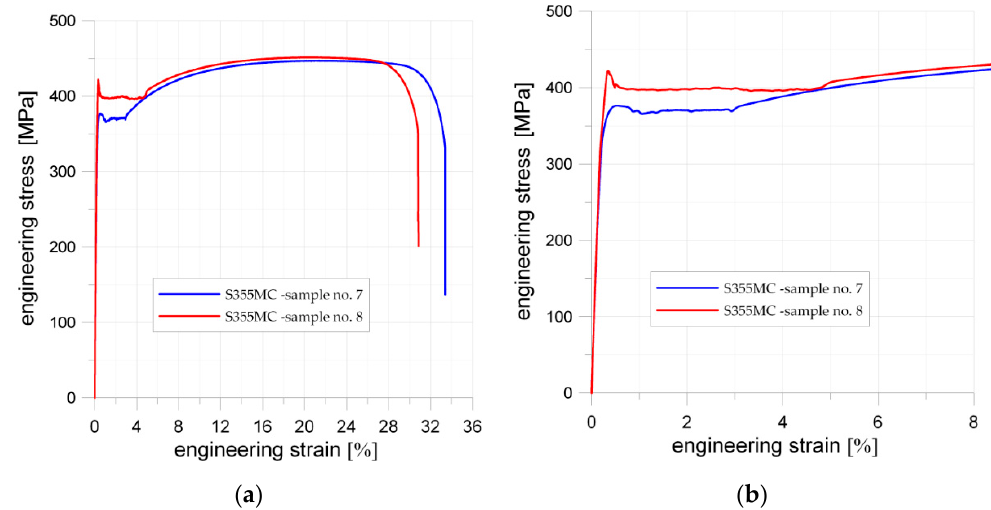
Figure 16. Tensile behavior of S355MC: ( a ) engineering σ – ε curves for tested specimens; and ( b ) engineering stress–strain curves for tested specimens—enlargement of the curve with elastic and plastic behavior of material.